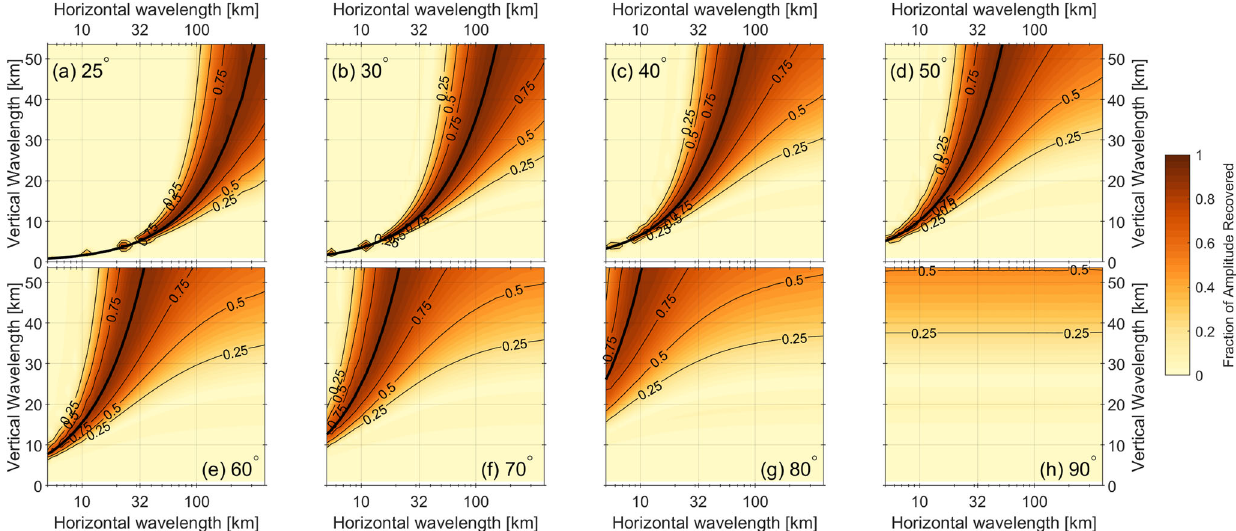
Fig. 2 Estimated effect of the observational fi lter for selected sub-limb viewing angles from 25 to 90°. a – h Colours and line contours show the fraction of the input signal amplitude recovered for GWs of this horizontal and vertical wavelength. The thick solid line shows the expected optimum visibility where the LOS angle σ aligns with the orientation of the phase fronts given by the ratio of vertical and horizontal